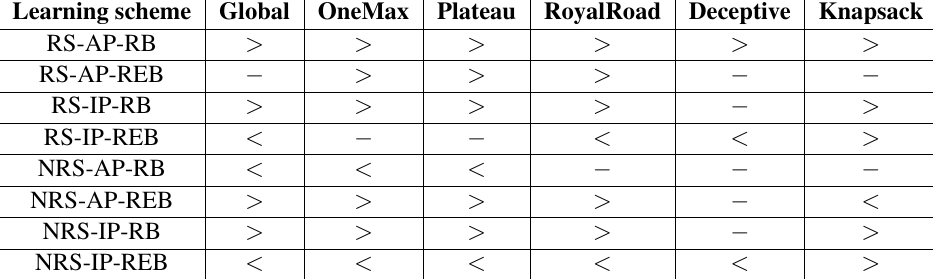
Algorithm portfolio based scheme for dynamic optimization problems Table 4. Learning vs. no learning. Results of the pairwise comparisons, using the Wilcoxon’s non- parametric test at a significance level of α = 0 . 05, between the learning schemes proposed and the variant of the algorithm portfolio without learning scheme (AP-NoLearn). The first column indi- cates the credit assignment scheme under consideration. The second column states the result of the comparison over all the problems and configurations. The rest of the columns correspond to the results in every problem. The ‘ > ’ sign states that the considered scheme is statistically better than AP-NoLearn, ‘ < ’ means the opposite, and ‘ − ’ indicates that the difference in performance is not